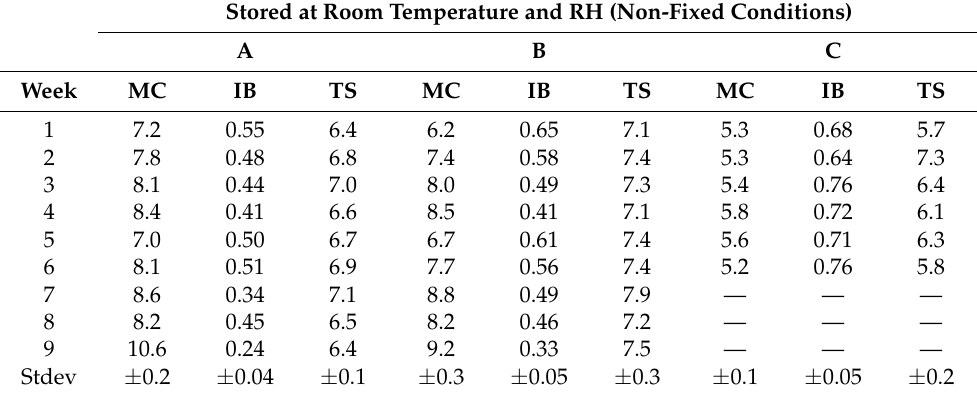
Table 2. Results for MDF board stored at room temperature and RH.